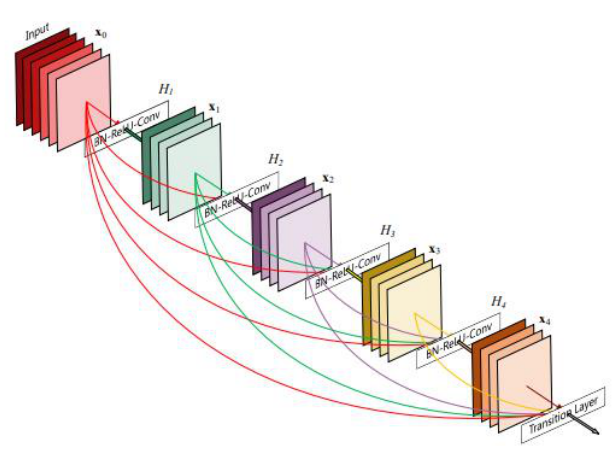
Figure 5. DenseNet Architecture